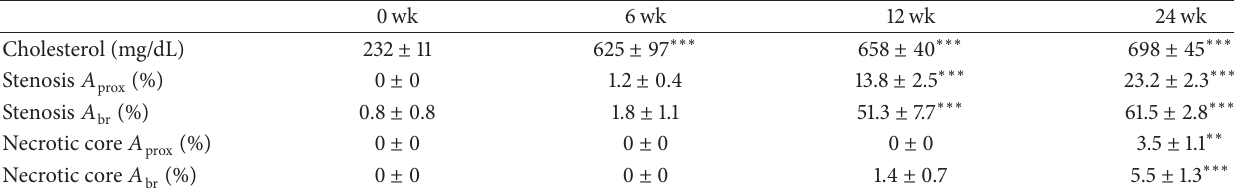
Table 2: Cholesterol and plaque parameters of ApoE −/− mice during atherogenesis.